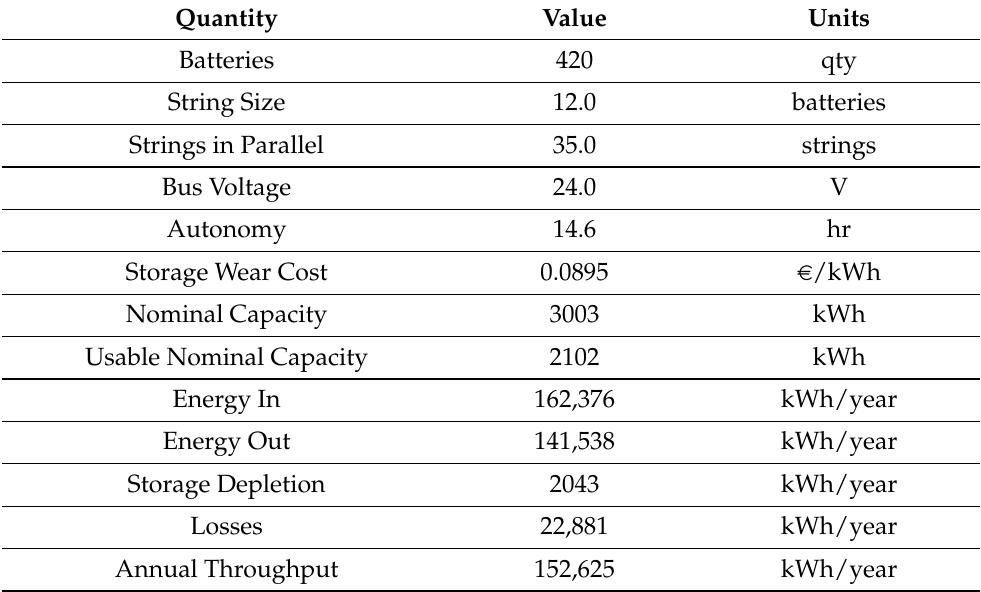
Figure 15. Battery State-of-Charge Scenario 2. Table 19. Battery Scheme Simulation Results.